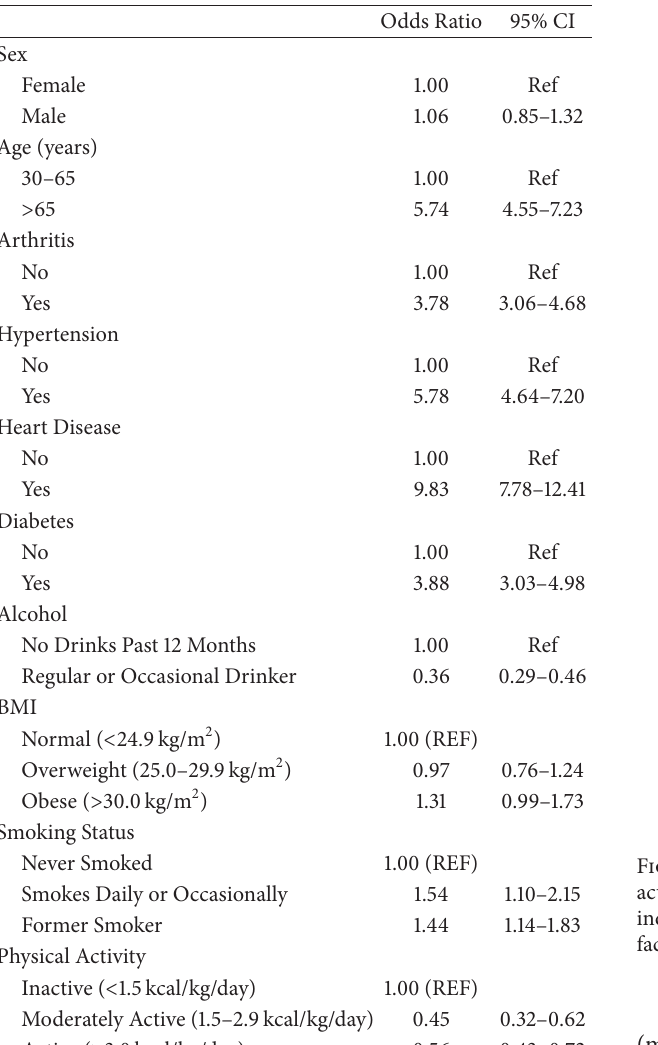
Table 2: Bivariate relationship between stroke risk factors.